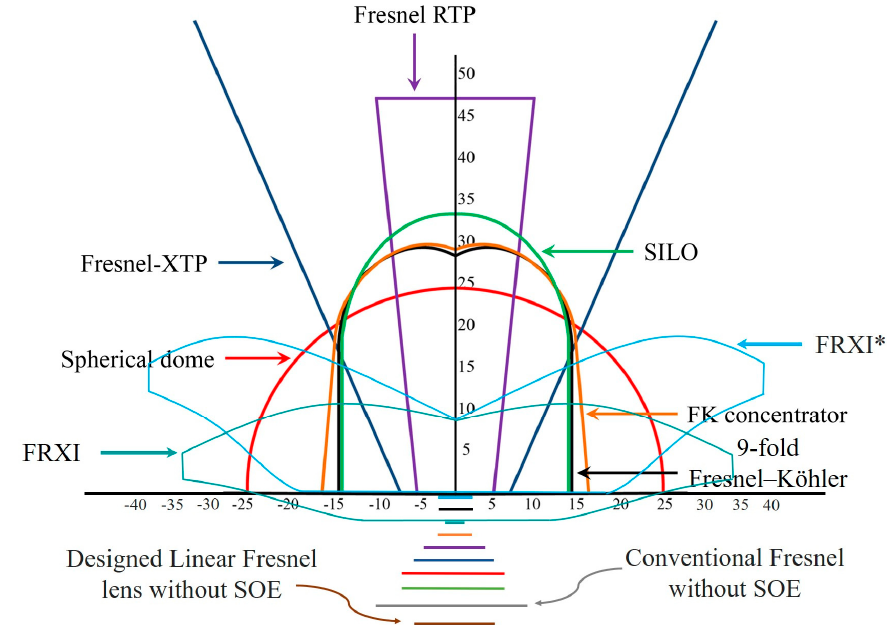
Figure 17. Cross section views of some types of SOEs and size comparison of these optical concentrator systems with the same acceptance angle. The structures and designs of these optical concentrator systems are described in detail in Miñano et al. [51] and Mendes-Lopes et al. [52].